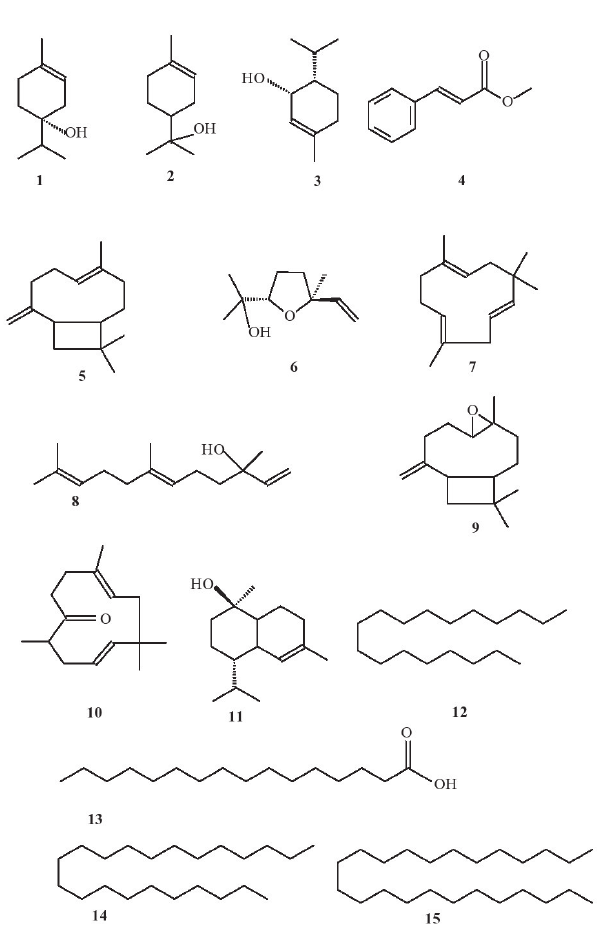
FIGURE 1 - Strectures of major compounds identified in AMFEO.